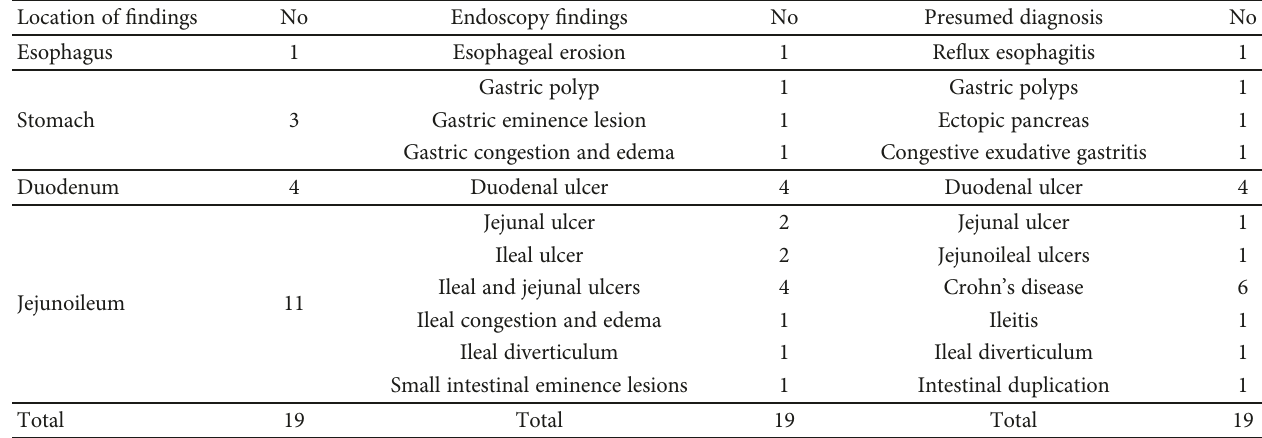
Table 1: Endoscopy fi ndings and presumed